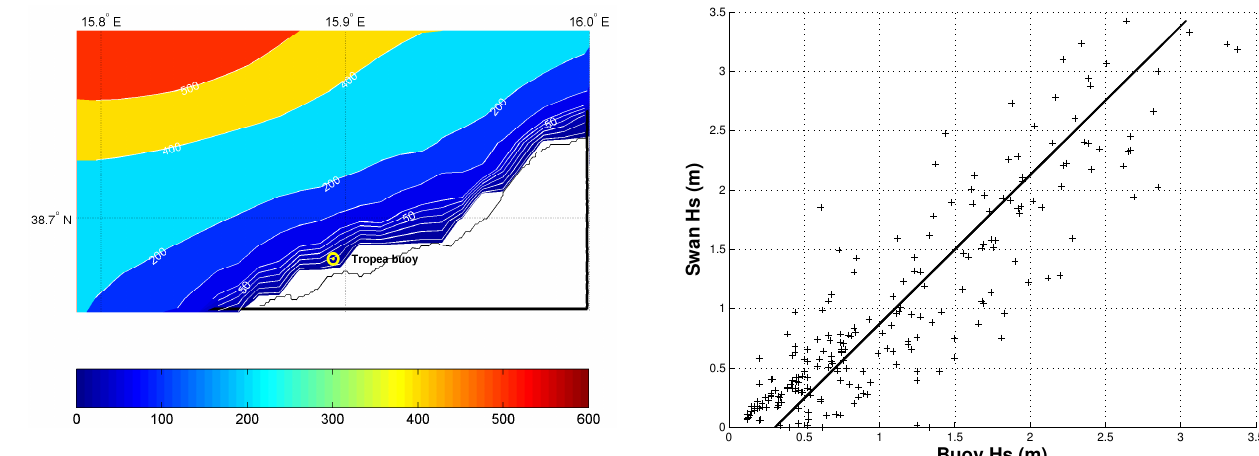
Fig. 13. Bathymetry and position of the buoy near Tropea.